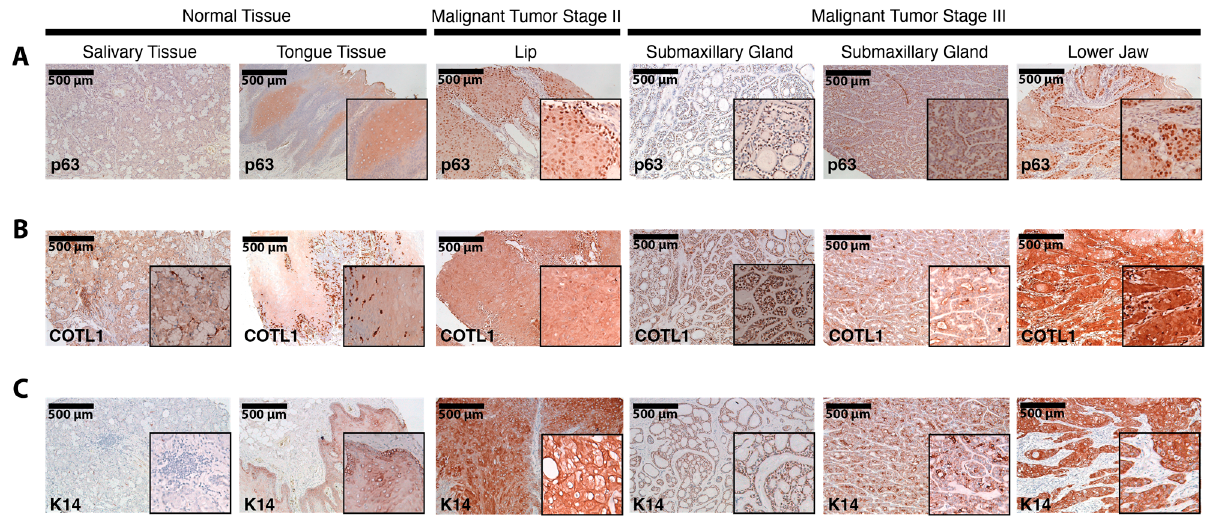
Figure 11. Immunohistochemical staining in HNSCC tumor microarray tissues. Staining of p63 ( A ), COTL1 ( B ), and K14 ( C ) across normal, malignant tumor stage II, and malignant tumor stage III tissues at 10X magnification.